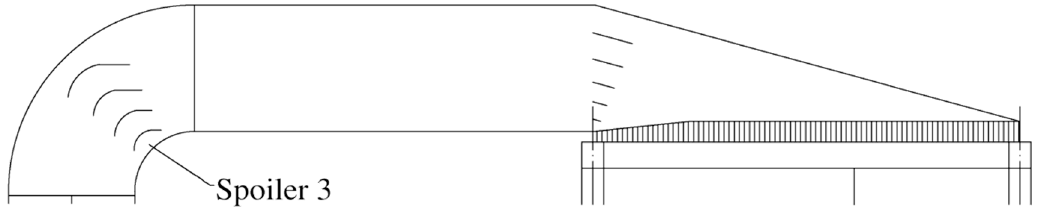
Figure 2. The structure diagram of guide vane arrangement. Table 4. Numerical simulation and optimization of SCR guide vane.